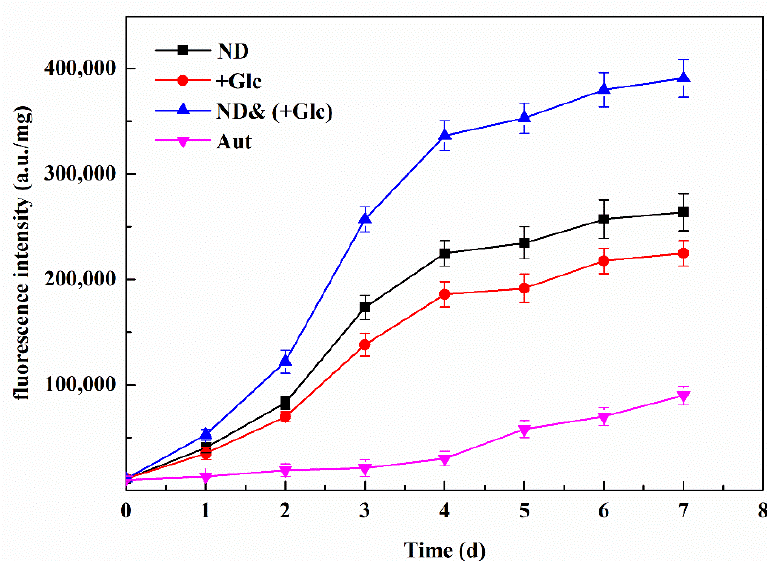
Figure 4. Changes in the fluorescence intensity in P. kessleri TY under different culture conditions. (The content of neutral lipids in cells is shown by the fluorescence intensity. Abbreviations: Aut. autotrophic; ND. nitrogen deficient; +Glc. mixotrophic (+Glucose); ND& (+Glc). nitrogen deficient & mixotrophic (+Glucose)). (Mean ± SEM, n = 3).